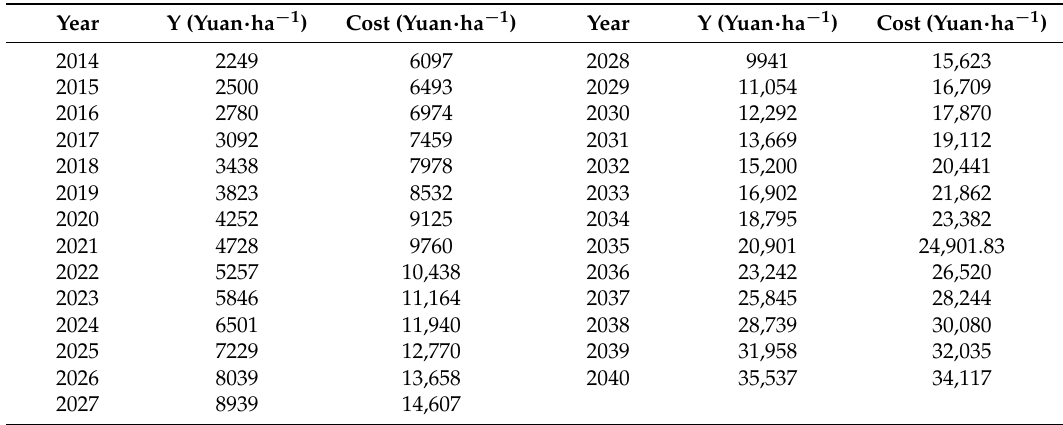
Table 11. Compensation standard